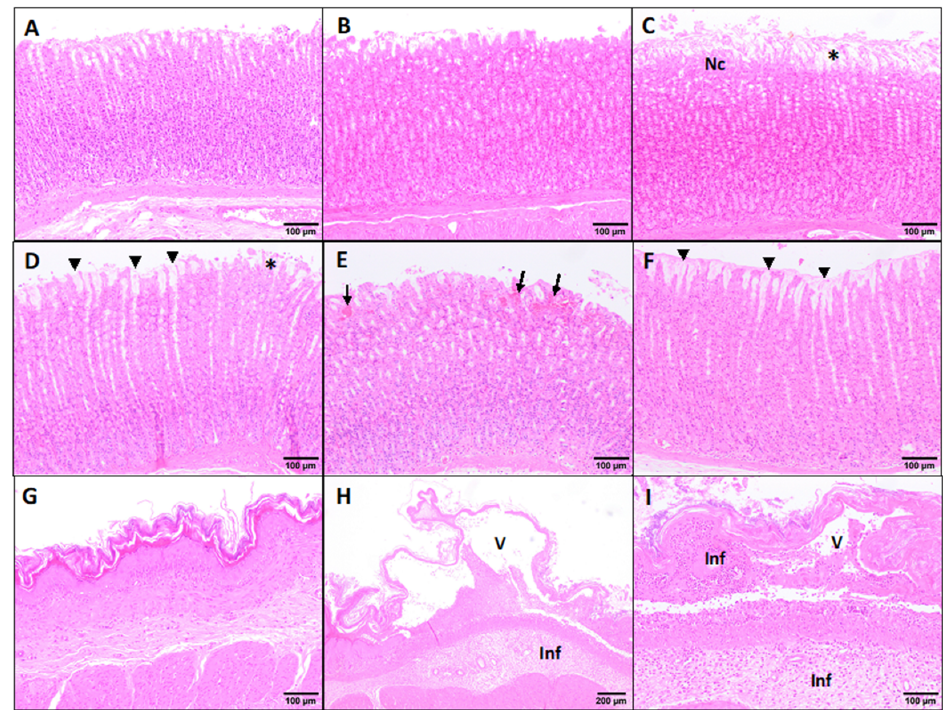
Figure 5. Histopathological changes in the stomach of rats exposed to PTS. ( A – C ) Glandular stomach of controls (negative, solvent, and positive, respectively); ( D – F ) Glandular stomach of PTS doses (55.0, 17.4, and 5.5 mg/kg, respectively); ( G – I ) Nonglandular stomach of negative control, positive control, and PTS 55.0 mg/kg dose, respectively. Hematoxylin and eosin stain. *: flaking epithelium of the gastric mucosa; Nc: focal necrosis of the apical gastric glands; arrow-head: hyper- trophy of the mucus cells; arrow: occasional hyperemia of the apical mucosa glands; V: vacuolation of the squamous epithelium in the mucosa; Inf: inflammatory infiltrates in the mucosa and submucosa. Livers from the negative and solvent controls showed no pathology findings apart from a normal physiological deposition of glycogen (Figure 6A,B). The lesions found in the positive controls were a mild multifocal distribution of hepatocyte degenerated in the surroundings of the central vein with occasional necrosis of hepatocytes (Figure 6C). Oc- casionally, there were areas filled with plasma and congestion. These lesions were signif- icantly different ( p < 0.05) in comparison to negative and solvent controls (Figure 4). More- over, PTS doses of 55.0 mg/kg displayed minimal inflammatory infiltrates apart from a minimal centrilobular degeneration of hepatocytes (Figure 6D) showing statistically sig- nificant differences ( p < 0.05) compared to the negative and solvent controls (Figure 4). However, PTS 17.4 and 5.5 mg/kg doses displayed minimal changes similar to the nega- tive and solvent controls (Figure 6E,F).